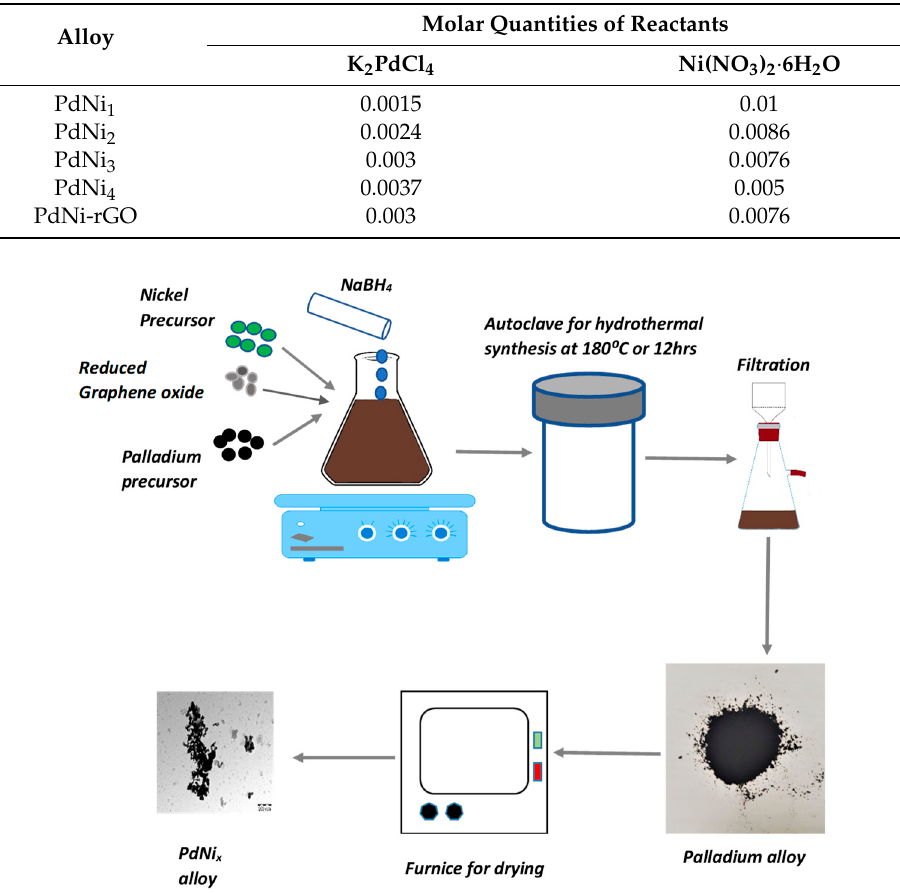
Figure 1. Procedure for hydrothermal synthesis of binary palladium alloys PdNi x.